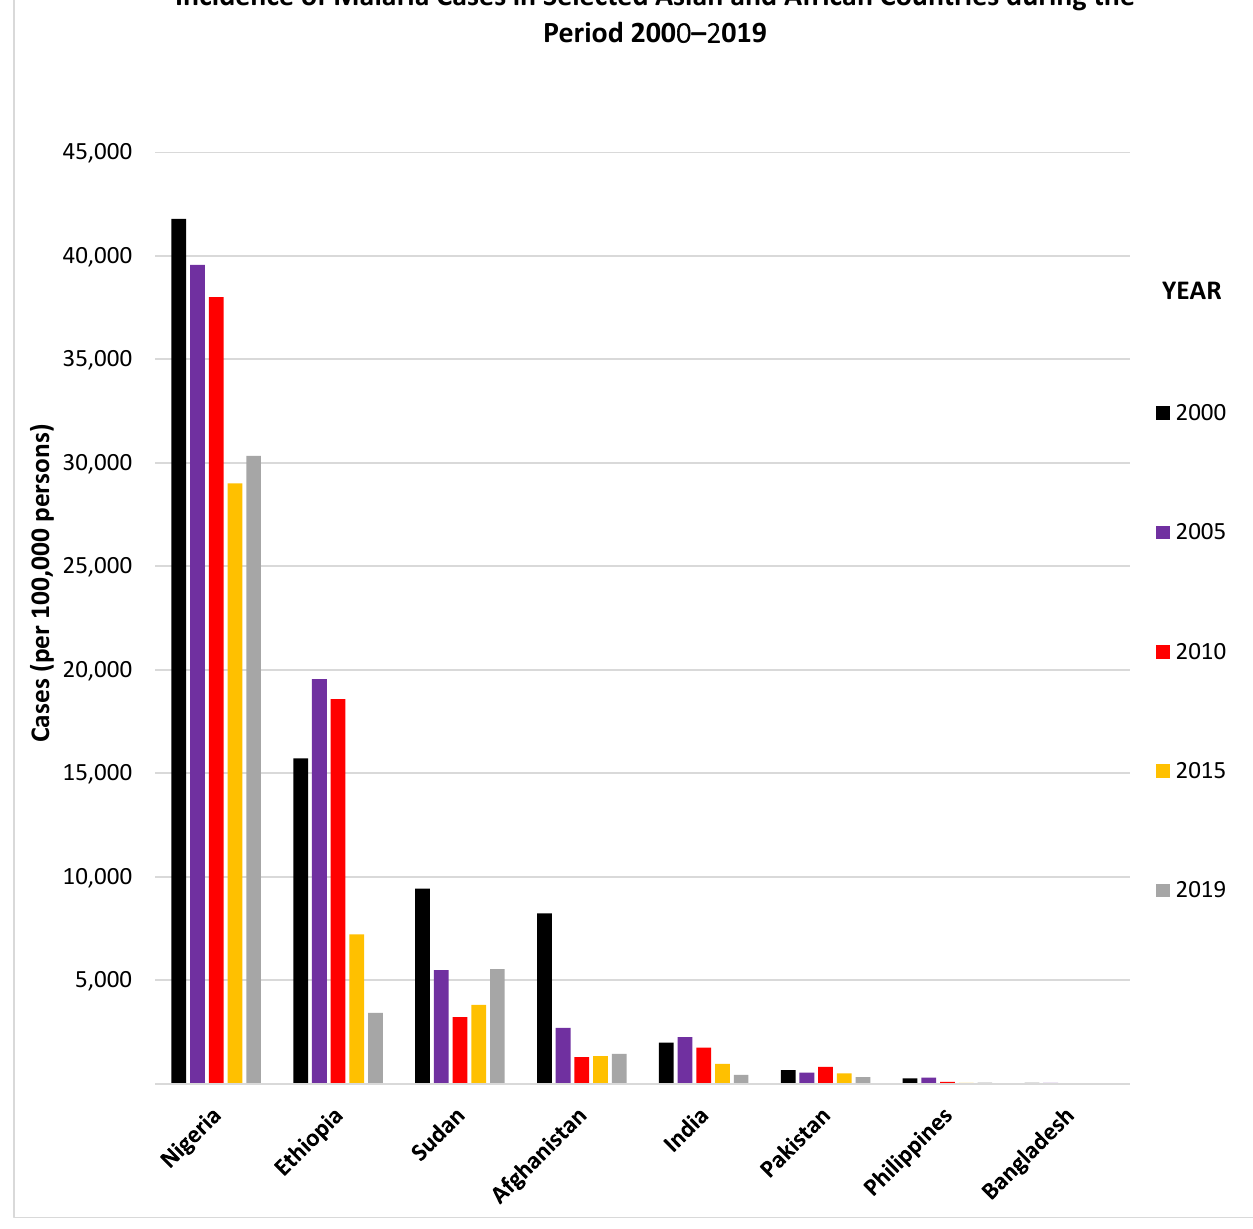
Figure 3. Incidence of malaria cases in selected Asian and African countries during the period 2000–2019. The graphs were made using data adopted from WHO, World Malaria Reports, 2019 and 2020 and the Malaria Atlas Project